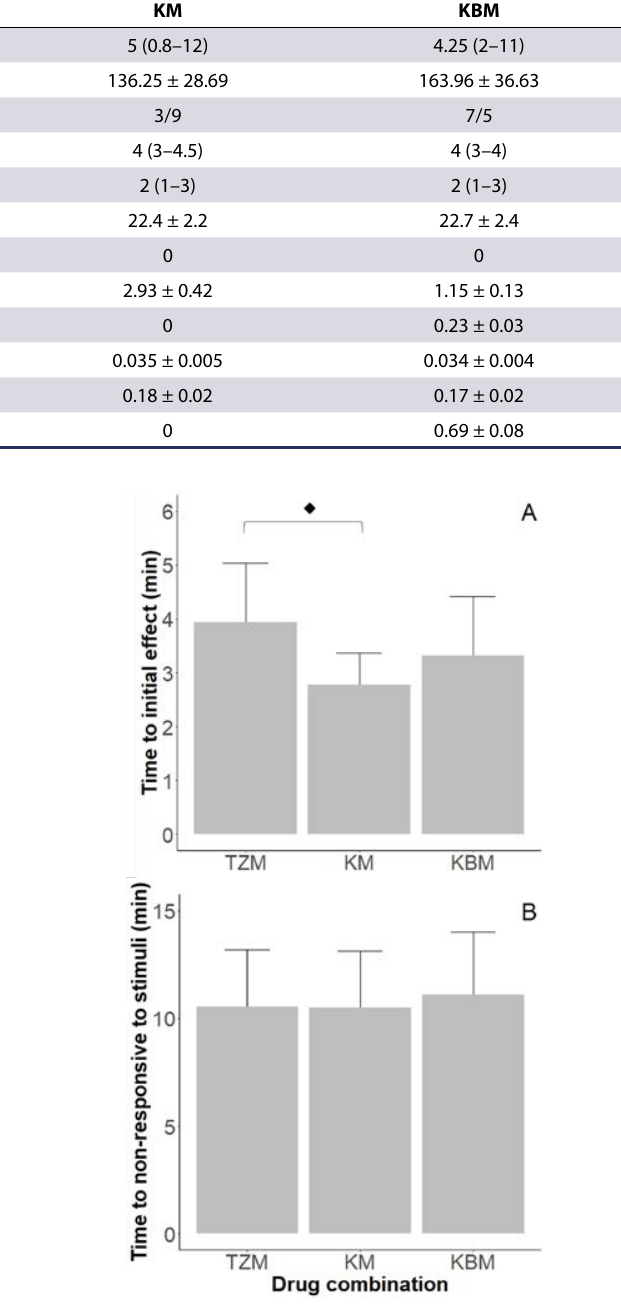
Figure 1: Mean and SD of A) time from darting to initial effect, and B) time from darting to animals being non-responsive to stimuli in free-ranging African lions ( Panthera leo ) immobilised with tiletamine- zolazepam-medetomidine (TZM), ketamine-medetomidine (KM) or ketamine-butorphanol-medetomidine (KBM). Note:  denotes a difference between TZM and